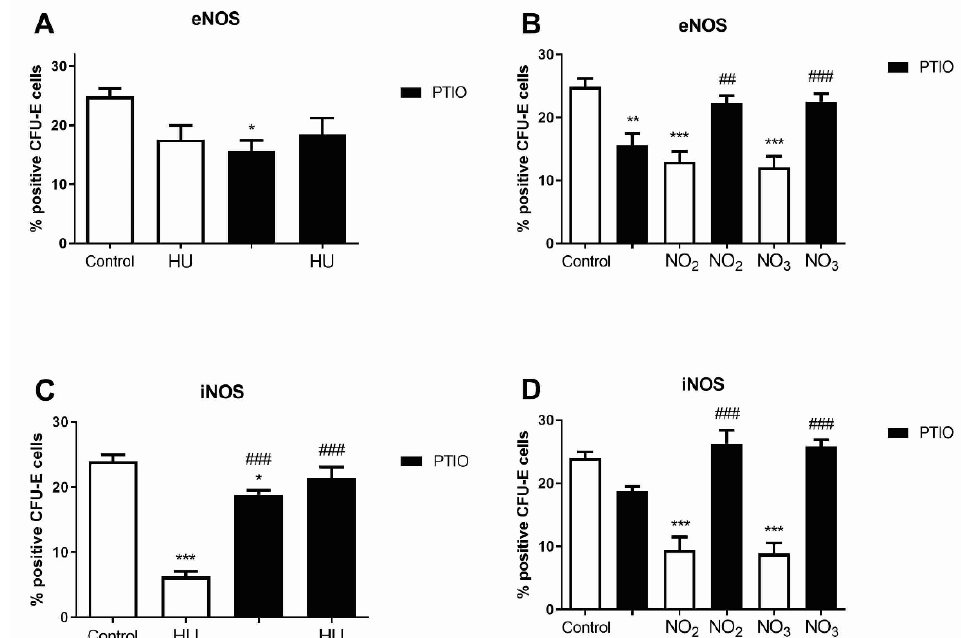
Figure 5. NOS levels in mouse ex vivo CFU-E colonies. Frequency of eNOS ( A , B ) and iNOS ( C , D ) positive cells in mice in vivo treated with hydroxyurea (HU) ( A , C ), sodium nitrite (NO 2 ), and sodium nitrate (NO 3 ) ( B , D ), with or without PTIO. The corresponding immunocytochemistry slides are in Supplemental Figure S2. Values are mean ± SEM ( n = 5). * p < 0.05, ** p < 0.01, and *** p < 0.001 vs. non-treated mice (Control); ## p < 0.01 and ### p < 0.001 vs. HU or NO 2 /NO 3 treated only.